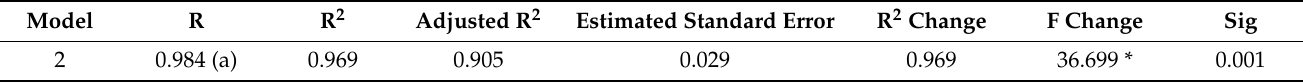
Table 8. GS results for multiple regression model